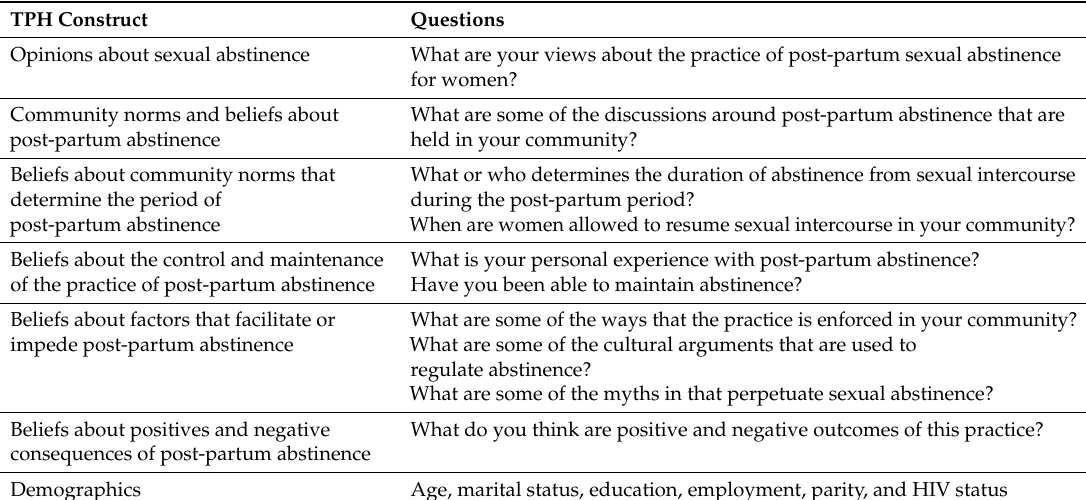
Table 1. Questions from the interview